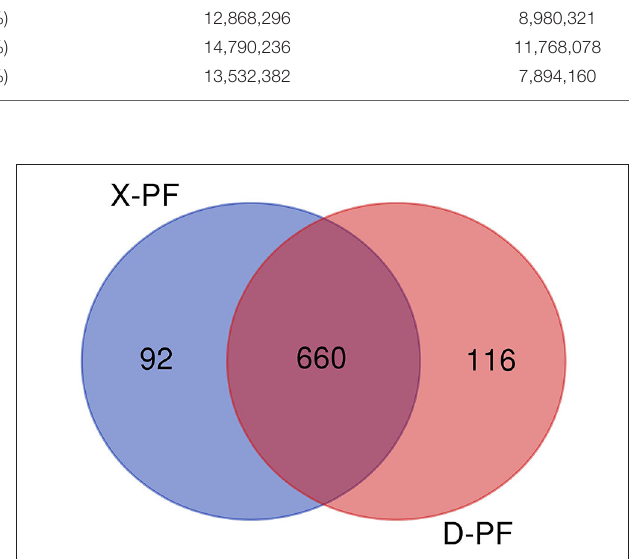
FIGURE 1 | miRNAs Venn diagram between two groups (D-PF vs. X-PF). D-PF represented the subcutaneous adipose tissue of Duolang sheep, X-PF represented the subcutaneous adipose tissue of Small Tail Han